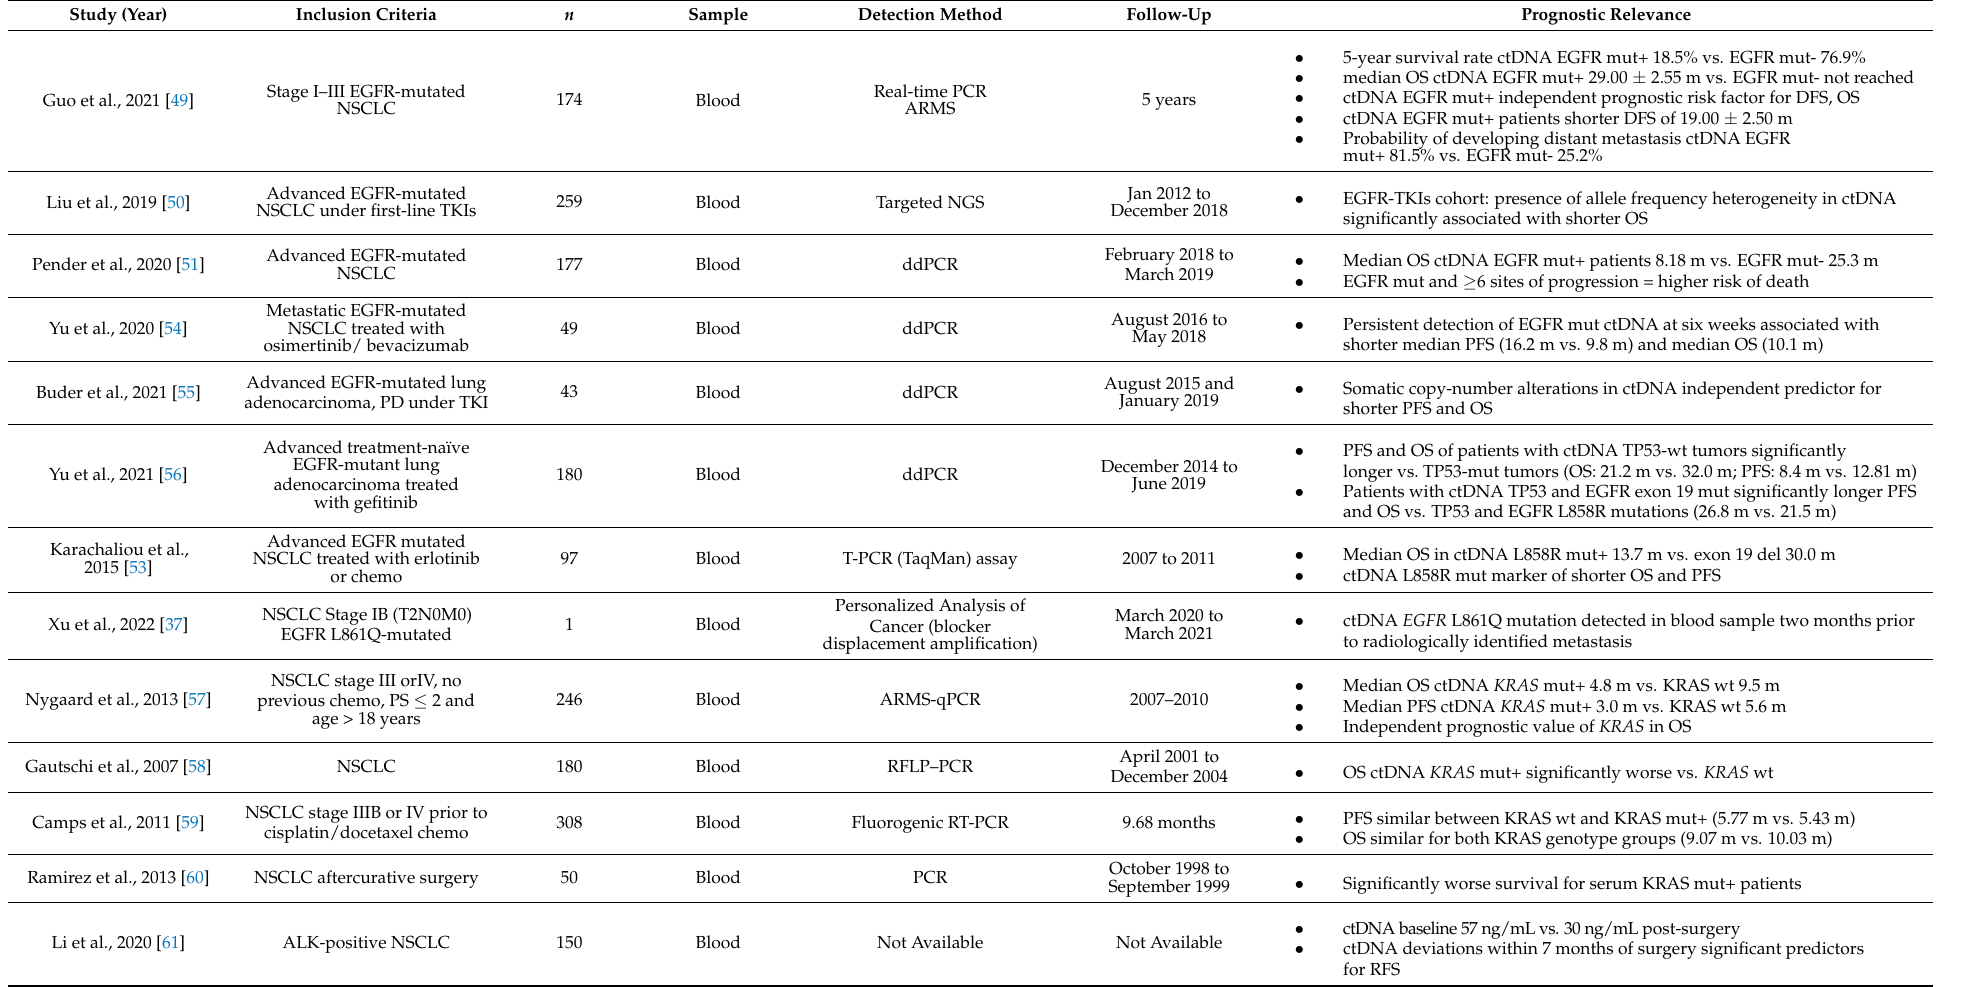
Table 1. Studies and findings focusing on prognostic ctDNA-based analyses in patients with oncogene-driven